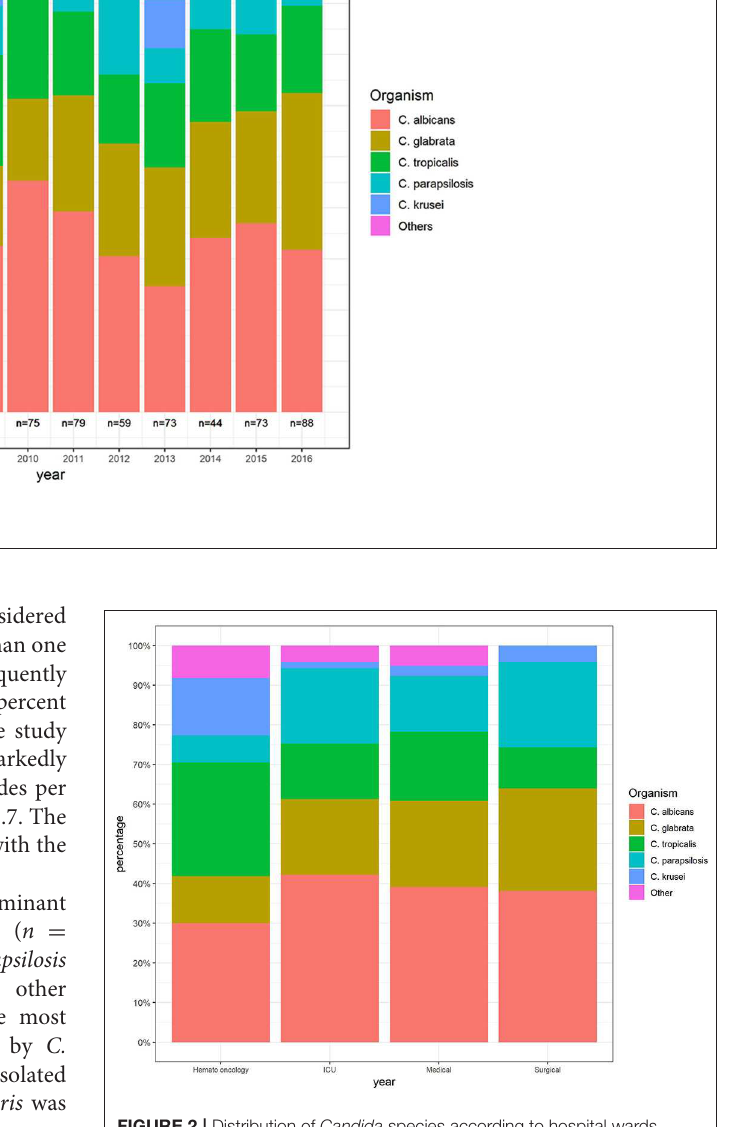
FIGURE 2 | Distribution of Candida species according to hospital